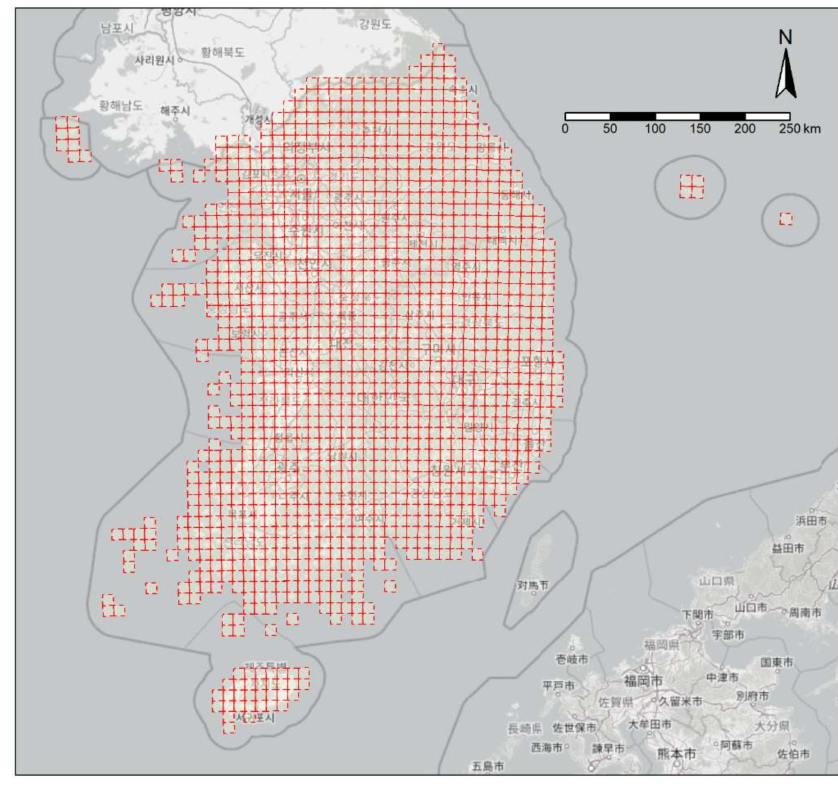
Figure 1. Study area covered by 10 km-by-10 km